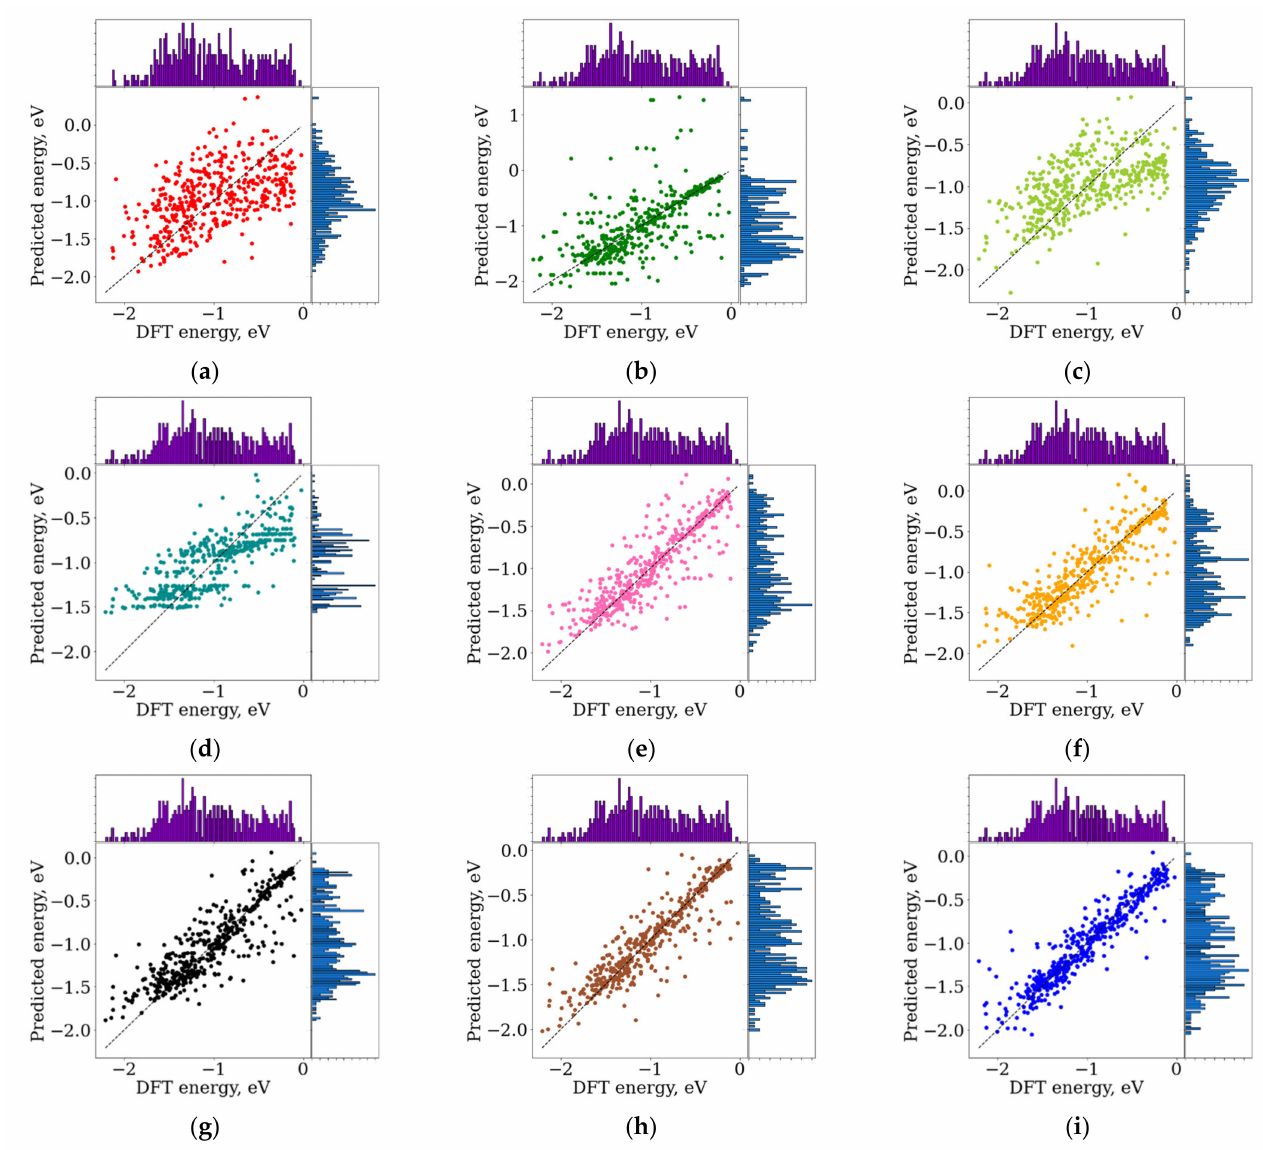
Figure 1. Machine learning (ML)-predicted vs. Density Functional Theory (DFT)-calculated binding energy in eV for different ML algorithms: ( a ) Ridge regression; ( b ) Decision tree; ( c ) Least abso- lute shrinkage and selection operator (Lasso); ( d ) AdaBoost; ( e ) XGBoost; ( f ) Gradient boosting; ( g ) Random forest; ( h ) Extra trees; ( i ) support vector machines (SVM). The entire interval of radial distribution functions (RDF) 0–7 Å from the carbon atom of CO was used as a descriptor. Histograms on the opposite axis represent distributions of respective values of